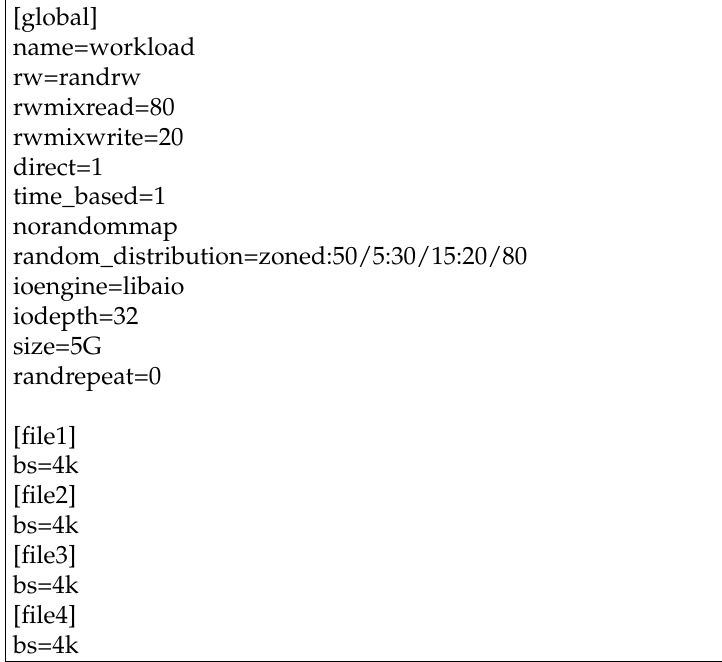
Figure 5. Configuration for the FIO